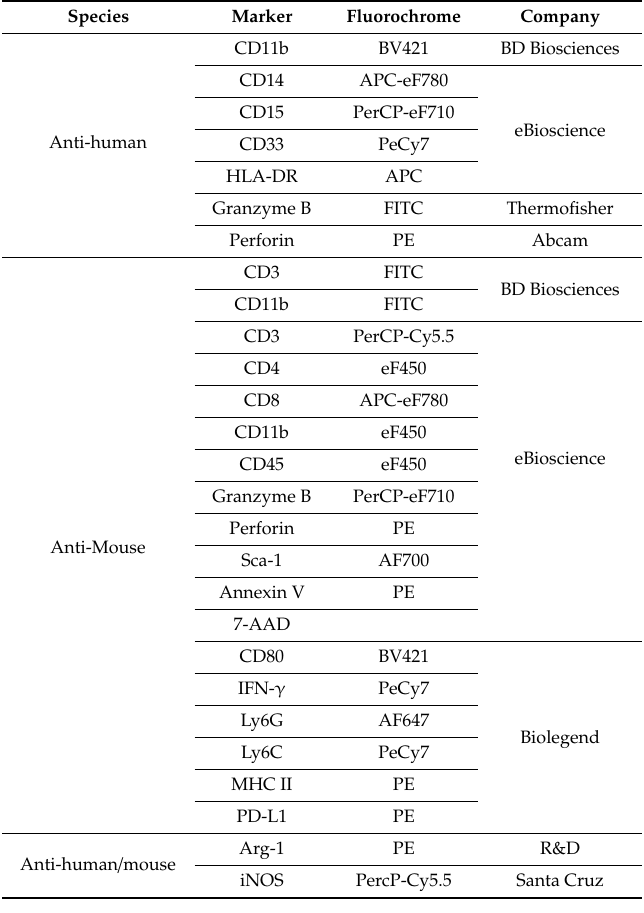
Table 1. Specifications of the used